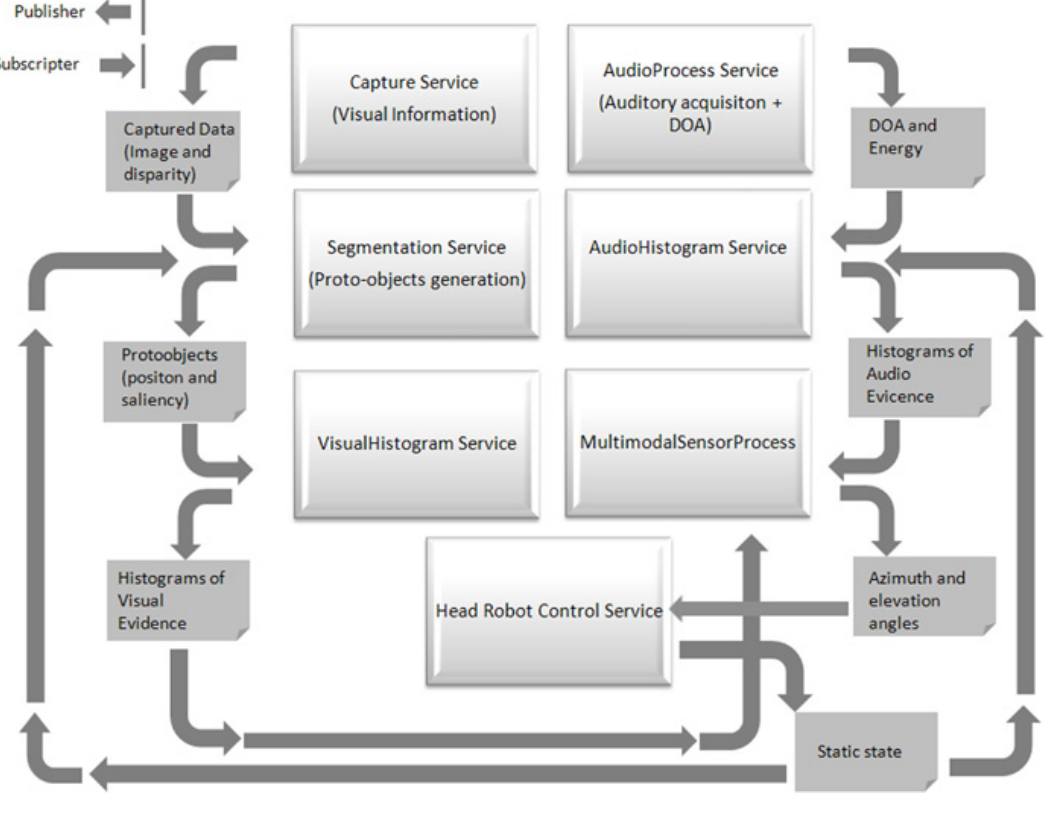
Figure 3. Services structure of the implementation of the multimodal